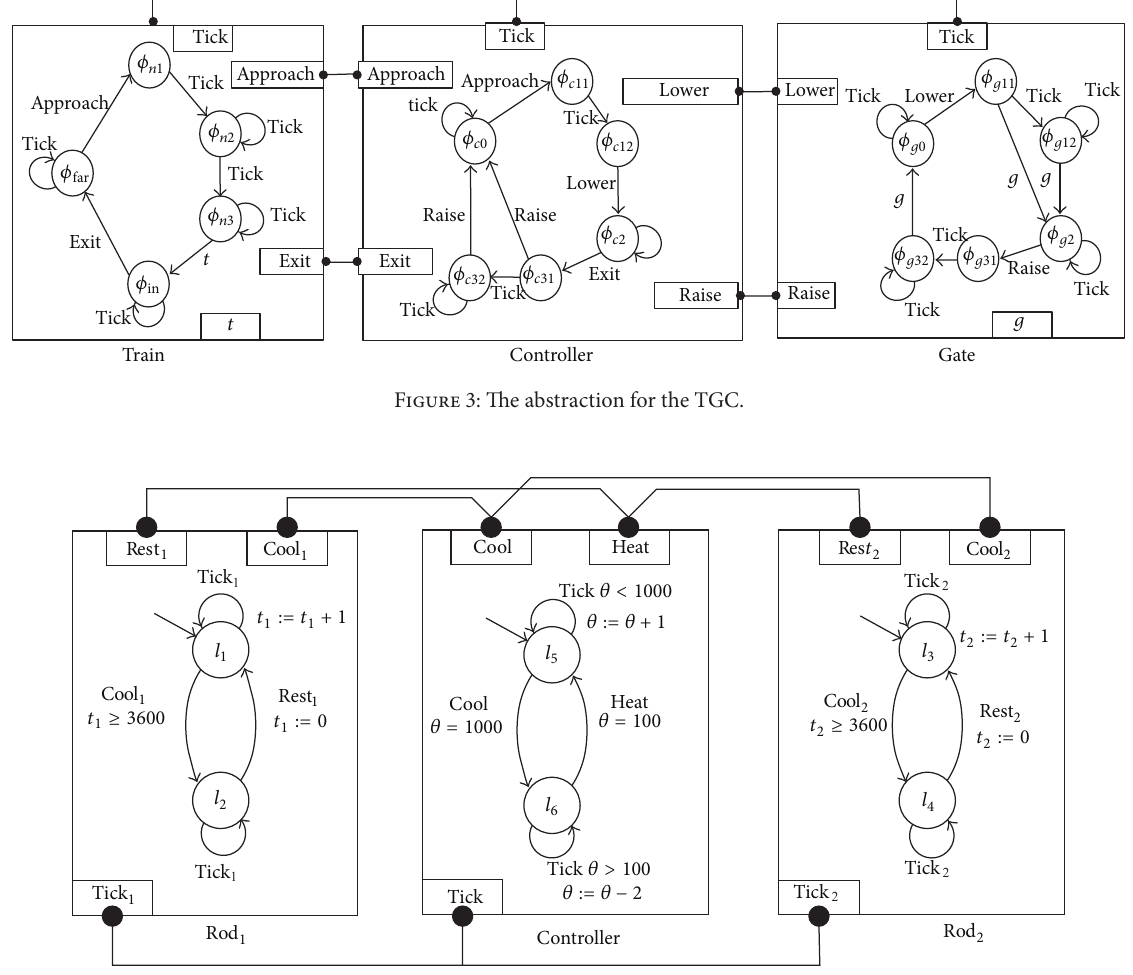
Figure 4: The component-based model for temperature control system.